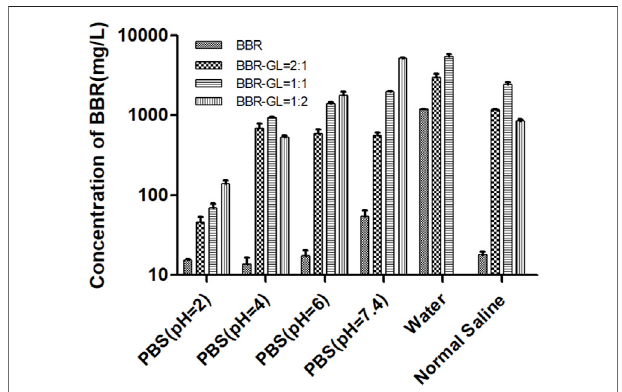
FIGURE 2 | Solubility of berberine was determined by preparing the BBR-GL complex with different proportions in different pH solutions using HPLC. Data are presented as mean ±